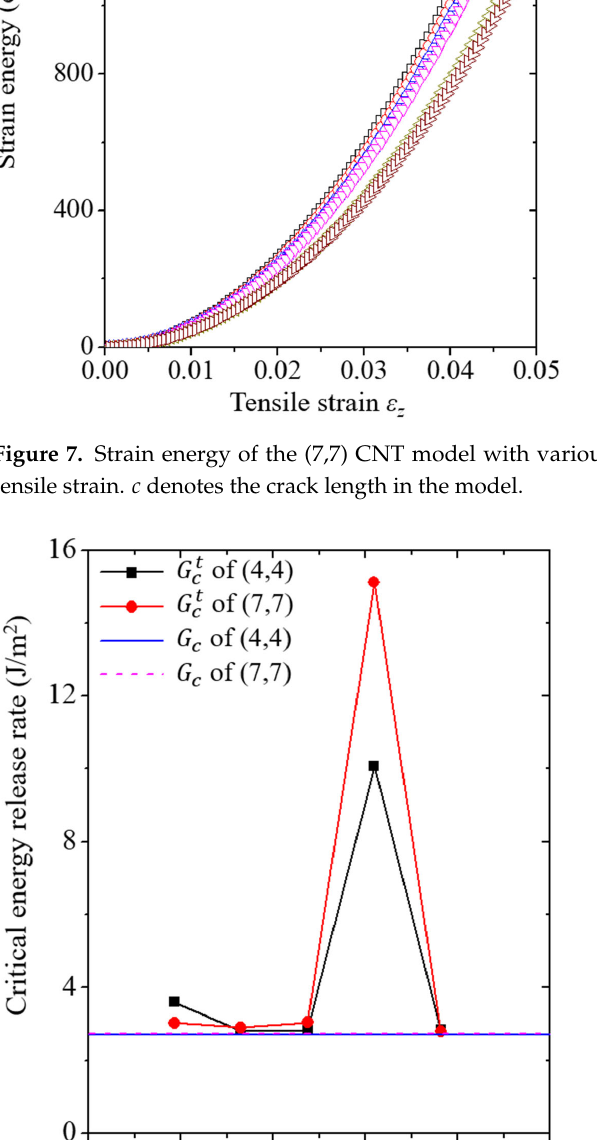
Figure 8. Comparison of the critical energy release rate of the simulation model between the two ‐ specimen method and Griffith criterion. G c denotes critical energy release rate values calculated by the Griffith criterion, which is equivalent to Equation (6). G ct denotes critical energy release rate values calculated by the two ‐ specimen method, which is equivalent to Equation (7).